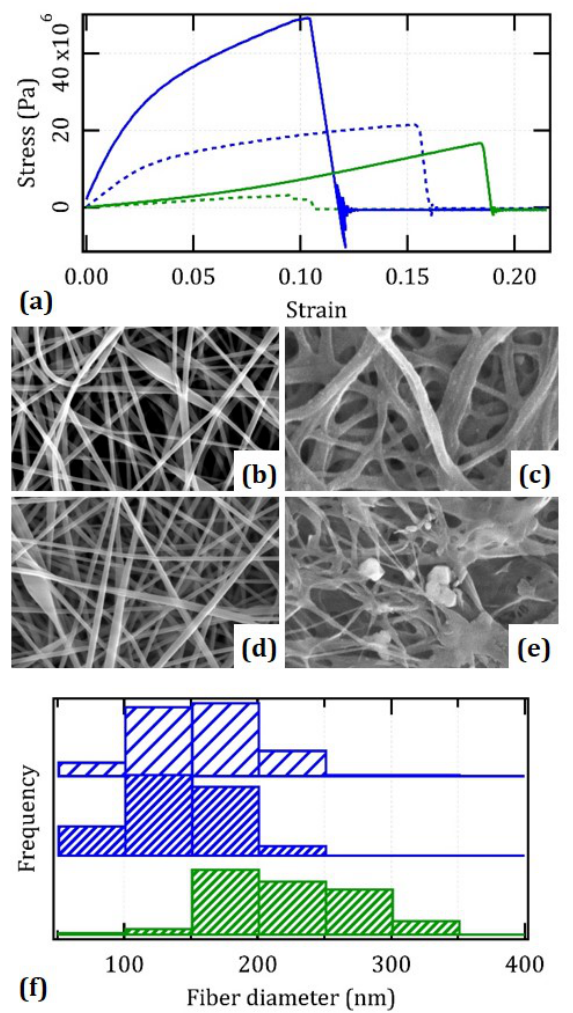
Figure 2. Tensile testing of the films and its microscopic interpretation: ( a ) representative stress–strain curves for the samples before (blue) and after (green) hydration in physiological buffer both before (dotted) and after (continuous) cross-linking. All curves were drawn from the nominal thickness of the films in air, i.e., 11 µ m. The 10 µ m × 6 µ m SEM micrographs of cross-linked ( b , c ) and as-spun ( d , e ) samples both before ( b , d ) and after ( c , e ) hydration. ( f ) Relevant distributions of fiber diameters computed both before (blue) and after (green) hydration, and before (light) and after (dark) cross- linking. Note that it was impossible to assess the fiber diameters in the case of the as-spun samples after hydration due to their largely compromised